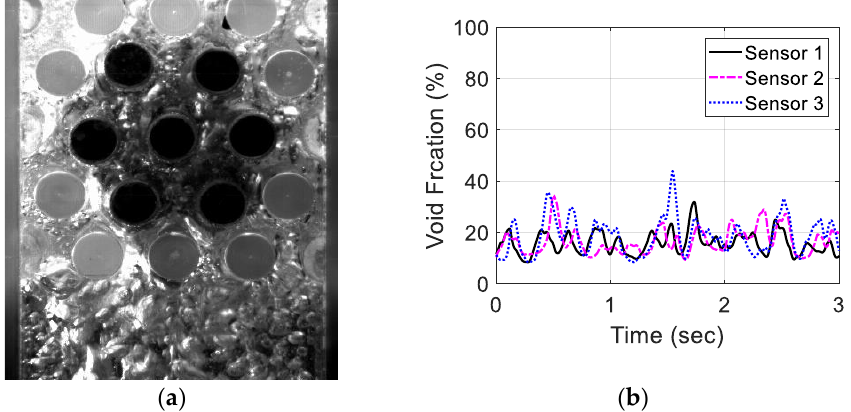
Figure 24. Experimental results for an air flow rate of 10 L/min for the three-sensor configuration: ( a ) flow visualization and ( b ) void fraction signal.